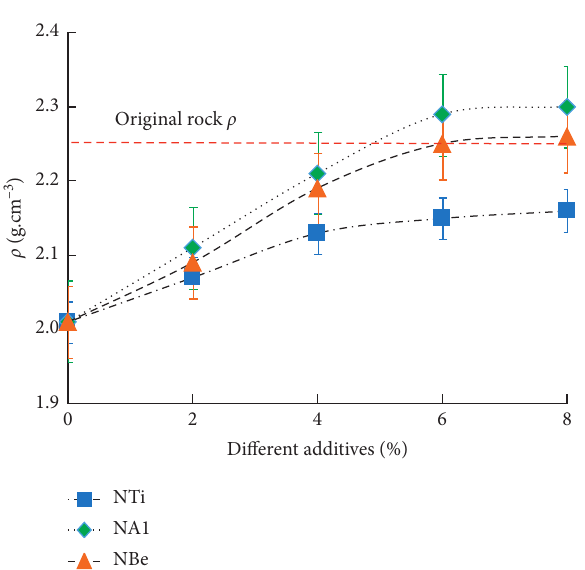
Figure 5: Effects of nanometer additives on expansion rate pa- rameters of similar